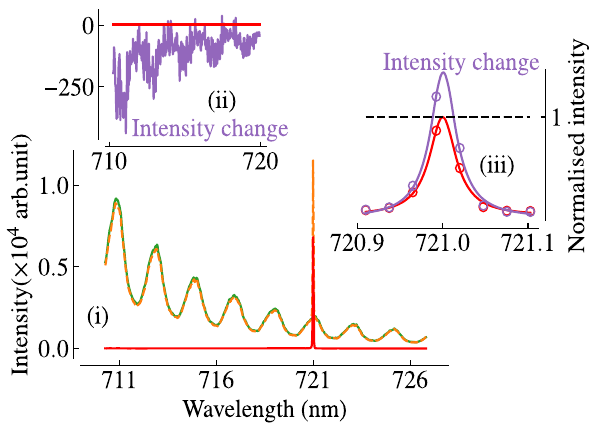
Figure 2: Typical experimental spectra obtained in cavity transmission. The green, orange, and red traces in (i) were obtained with green laser only, with the green plus red laser, and with the red laseronlypresent,respectively.Themodulationpatternwithaperiod of about 2.11 nm in (i) is due to the weak cavity modes formed inside thediamondcrystalitself.Subtractingthegreentracefromtheorange traceyieldsthepurpletracein(ii) andthedatapointsshownin(iii)as purplecircles(annotated as theintensitychange inboth fi gures).The red trace in (ii) is the spectrum with only the red laser near 721 nm present shown in (i). The red and purple lines shown in (iii) is the Lorentzian fi t to the data points shown in respective colours. In the trace with green plus red laser present, a slight decrease in the spontaneousemissionoccurscomparedtothegreenlaseronlytrace, which is apparent in (ii). Ampli fi cation of the red laser is apparent at the cavity mode resonant with the red laser in